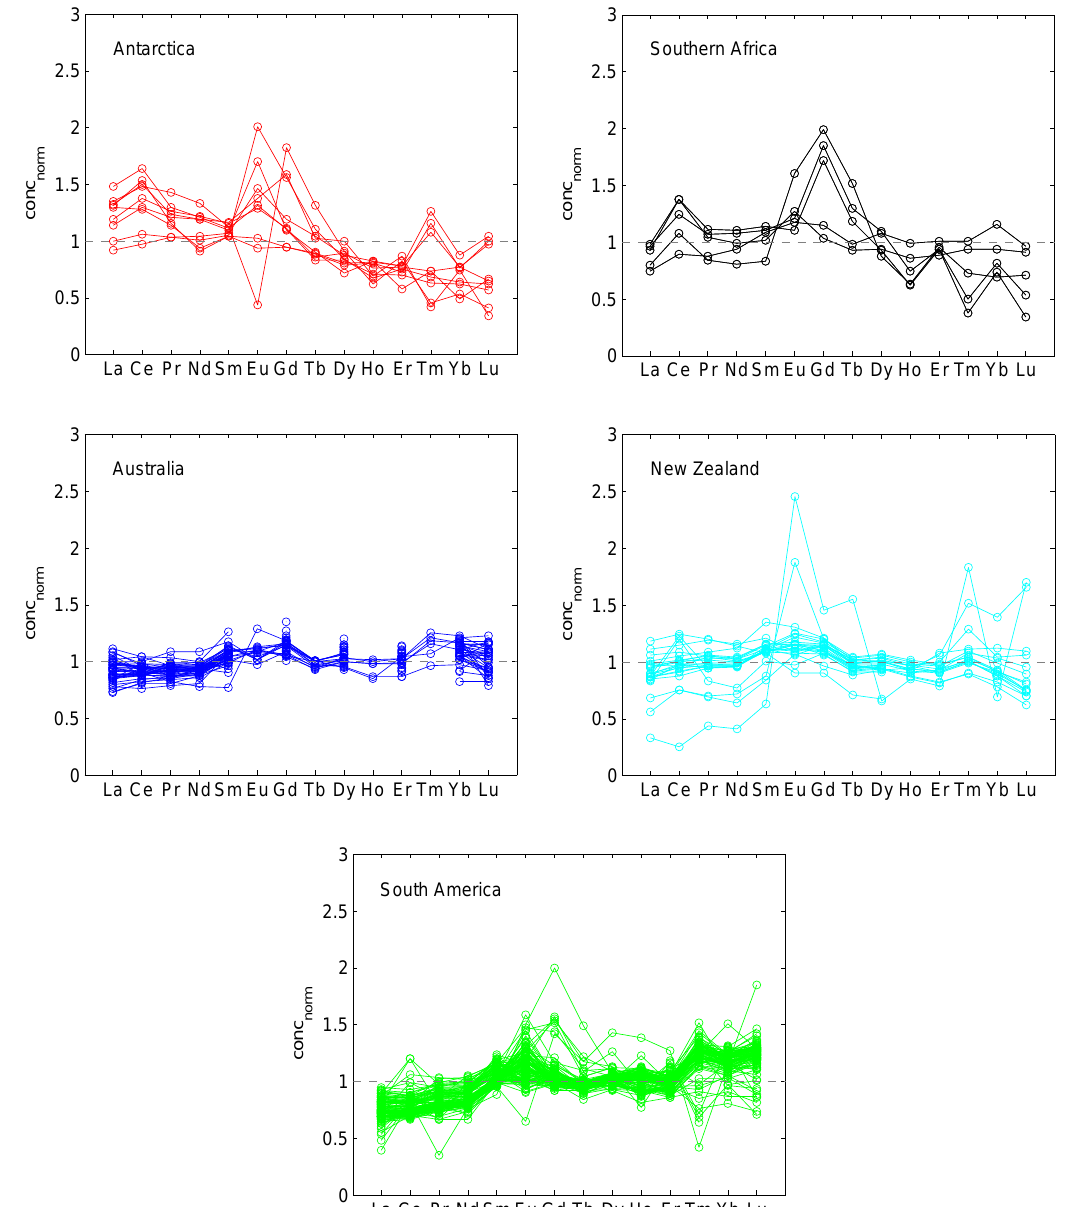
Fig. 6. REE patterns in the samples from the PSAs.